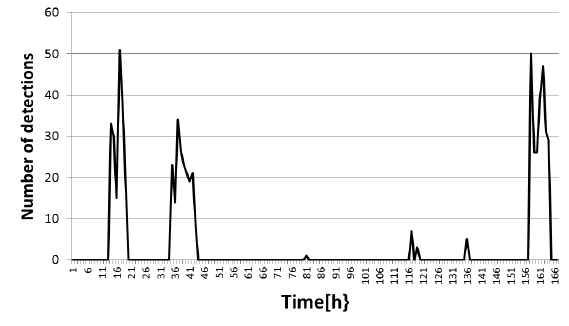
Figure 9: Decreasing ratio D r ( δ ) of signature No.7, 8, 11, 22.